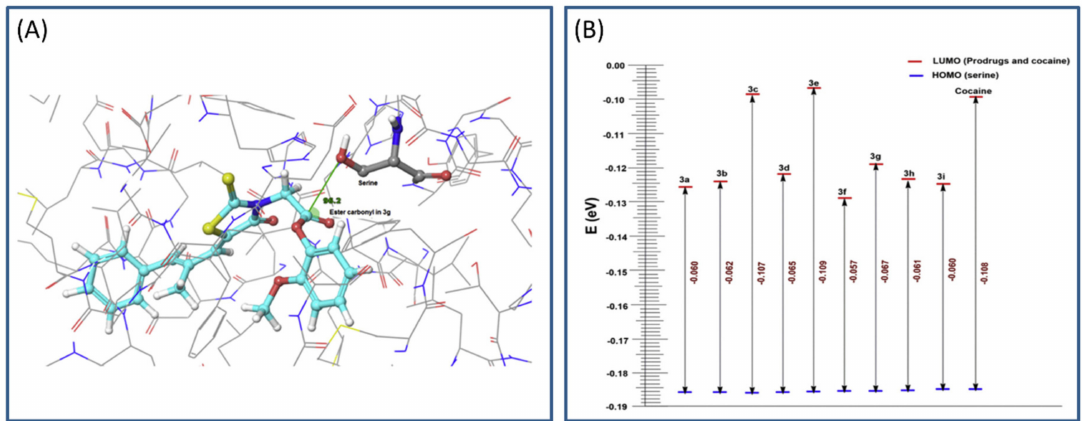
Figure 3. Representation of highest occupied molecular orbital-lowest unoccupied molecular orbital (HOMO-LUMO) gap ( A ) and Burgi–Dunitz angle between hydroxyl group of serine and ester carbonyl of the optimal prodrug (epalrestat-guaiacol) ( B ). Reproduced with permission from